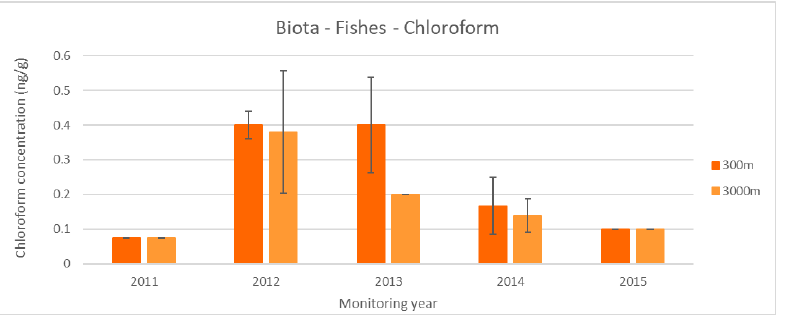
BAR values are shown in Table 3.